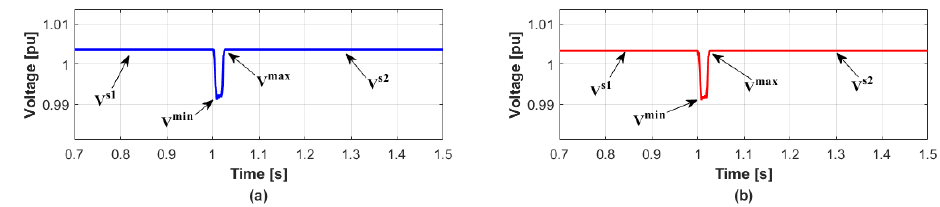
Figure 4. Voltage responses without the reactive power compensation in Case 1. ( a ) Bus 2 ( b ) Bus 3.